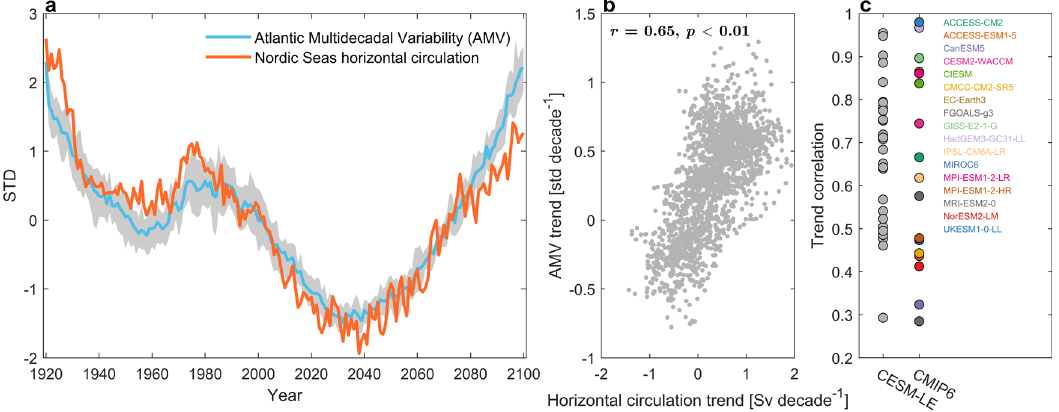
Fig. 5 | Horizontal circulation and Atlantic Multidecacal Variability (AMV). a StandardizedtimeseriesofhorizontalcirculationstrengthintheNordicSeasand the AMV index in CESM-LE. For the AMV, solid line shows the ensemble mean and the shading indicates the interquartile spread. Only the ensemble mean is shown for the horizontal circulation. The AMV index is calculated from low-frequency